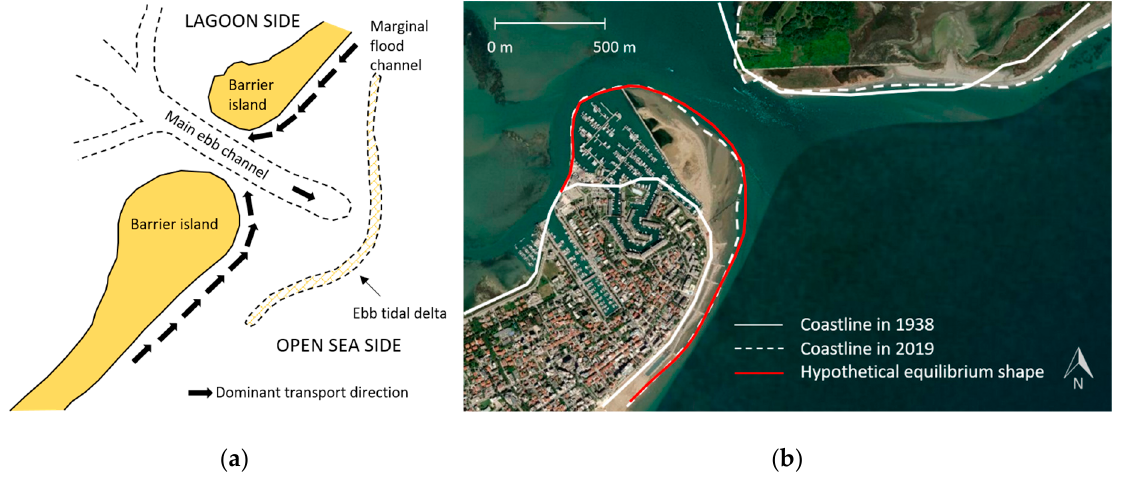
Figure 6. ( a ) Morphological model of a typical mesotidal inlet with drumstick shape barrier islands; ( b ) hypothetical equilibrium shoreline according to the scheme ( a ) and comparison of the equilibrium coastline in 1938 and the current one.